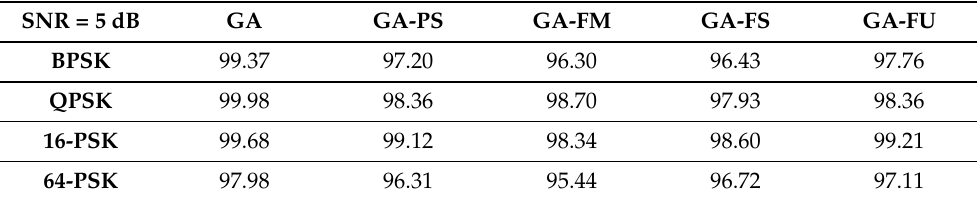
Table 2. ACA for M-PSK signals with